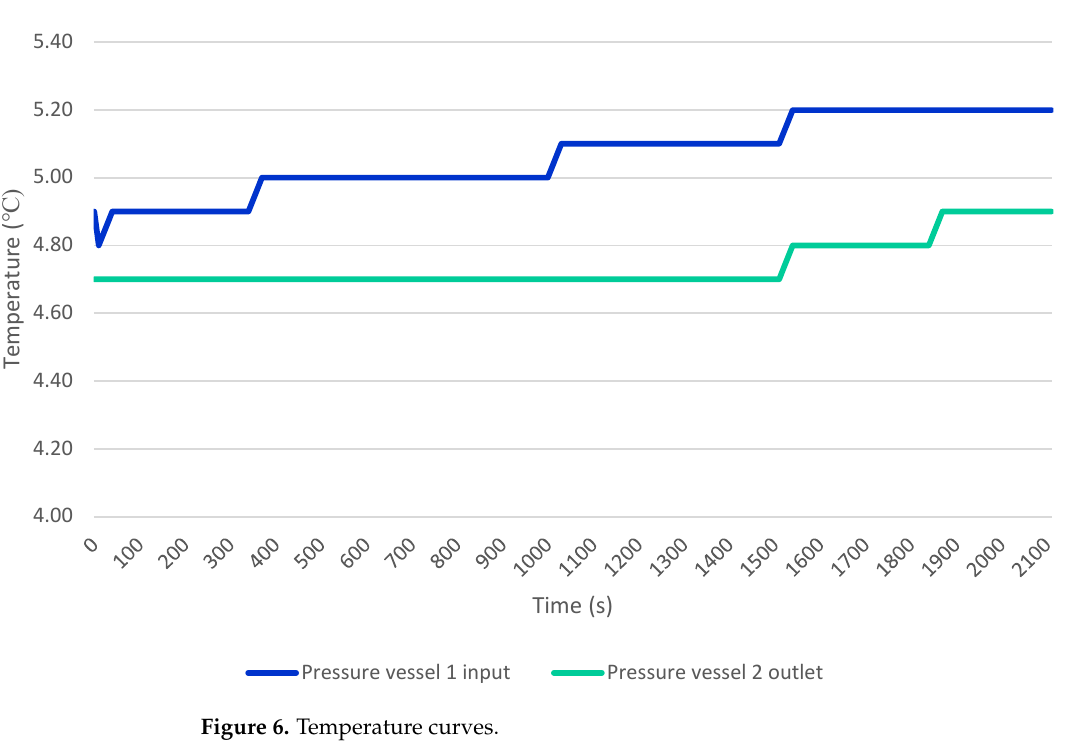
Figure 6. Temperature